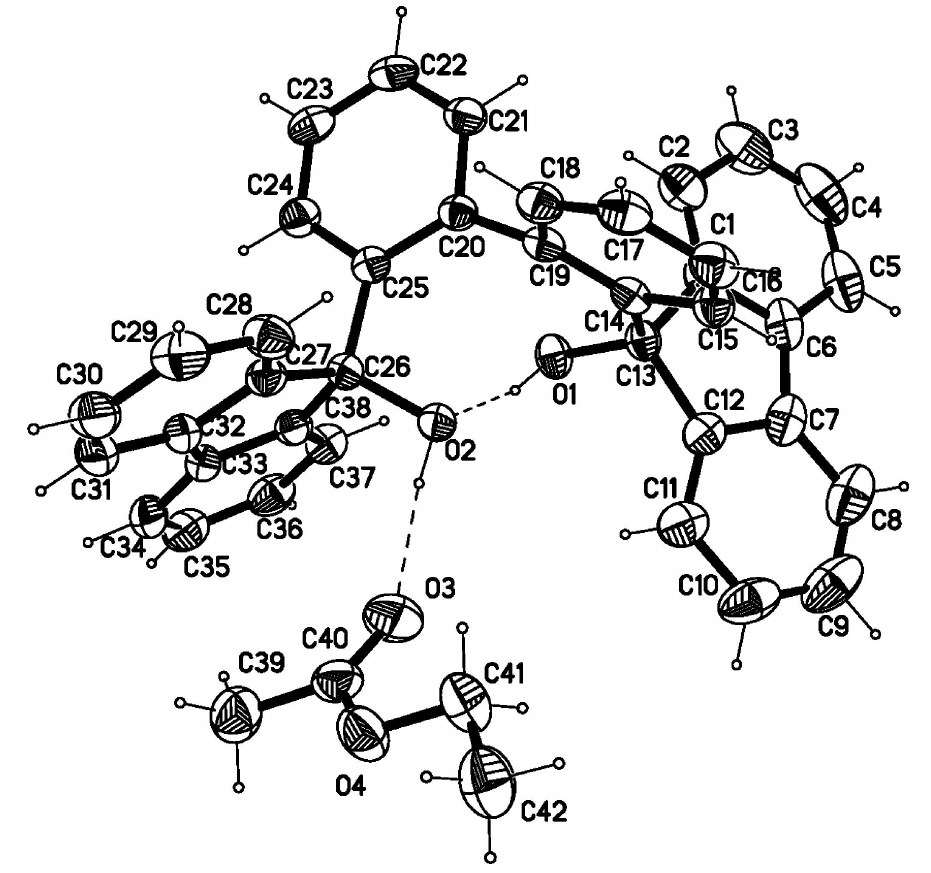
Figure 1 Perspective view of the title compound, showing 30% probability displacement ellipsoids for the non-H atoms. Dashed lines represent hydrogen